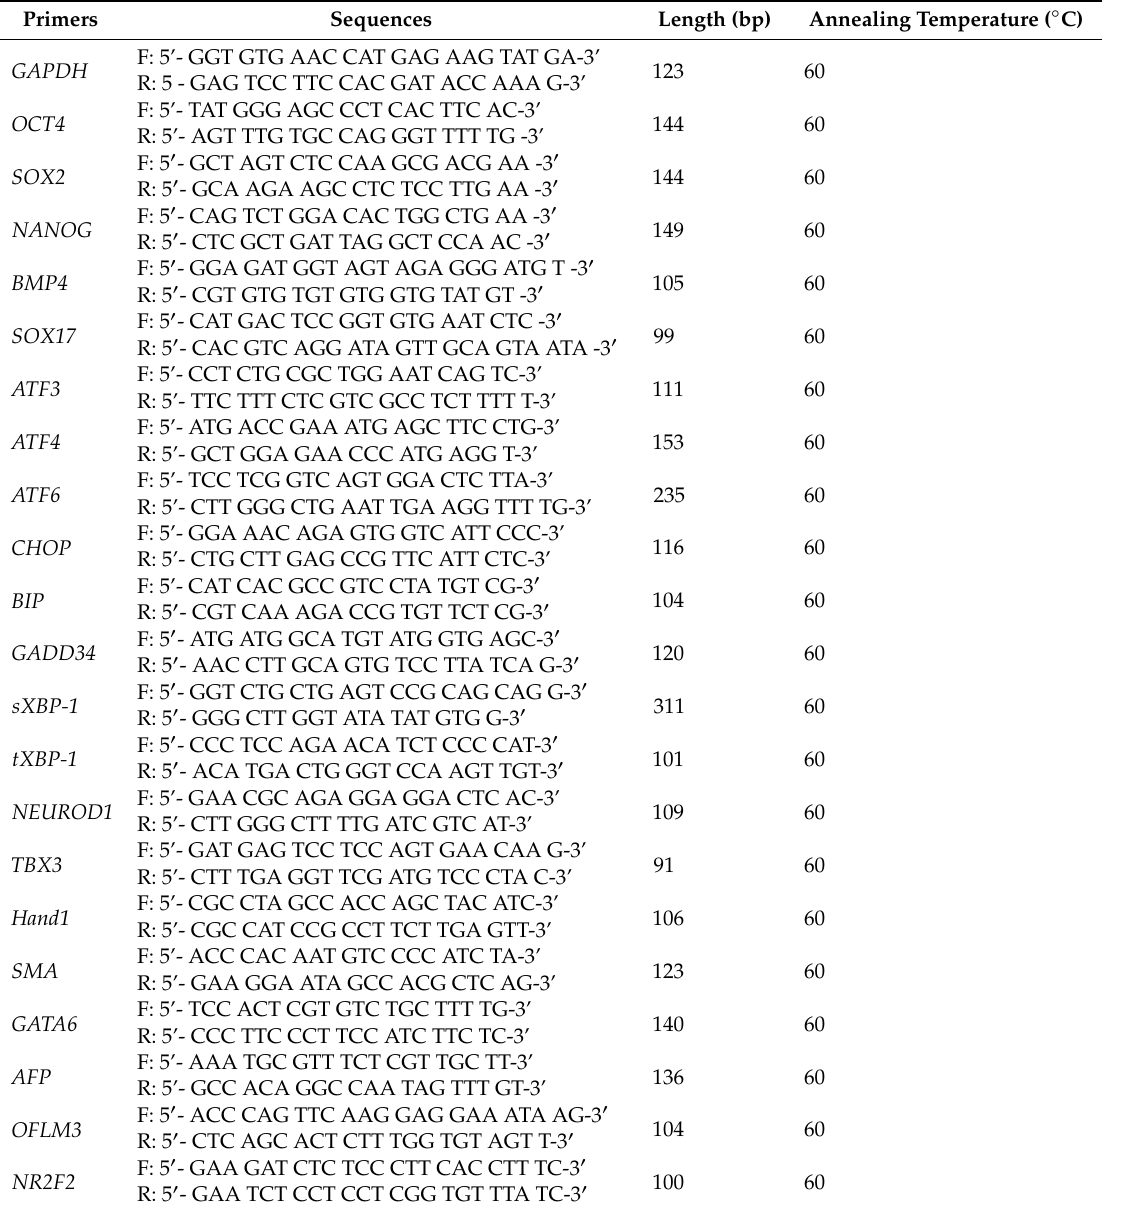
Table 1. The sequence of primers used in